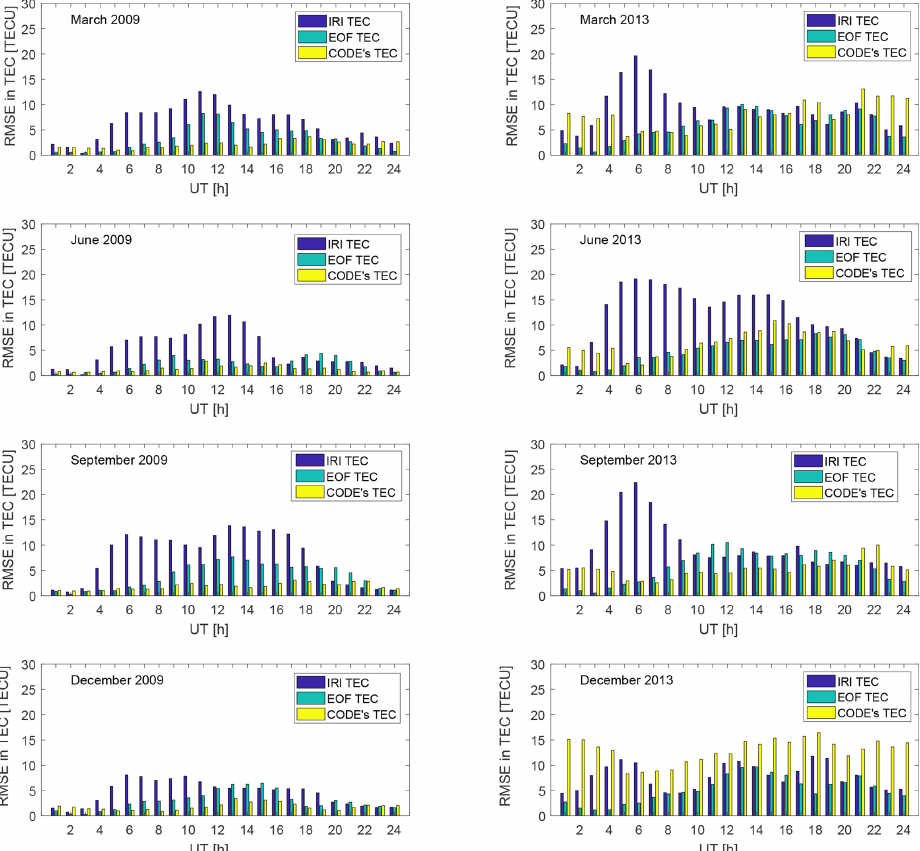
Figure 5. Diurnal variation of root-mean-square error (RMSE) of IRI TEC, CODE’s TEC and EOF TEC relative to GPS TEC over Malindi.